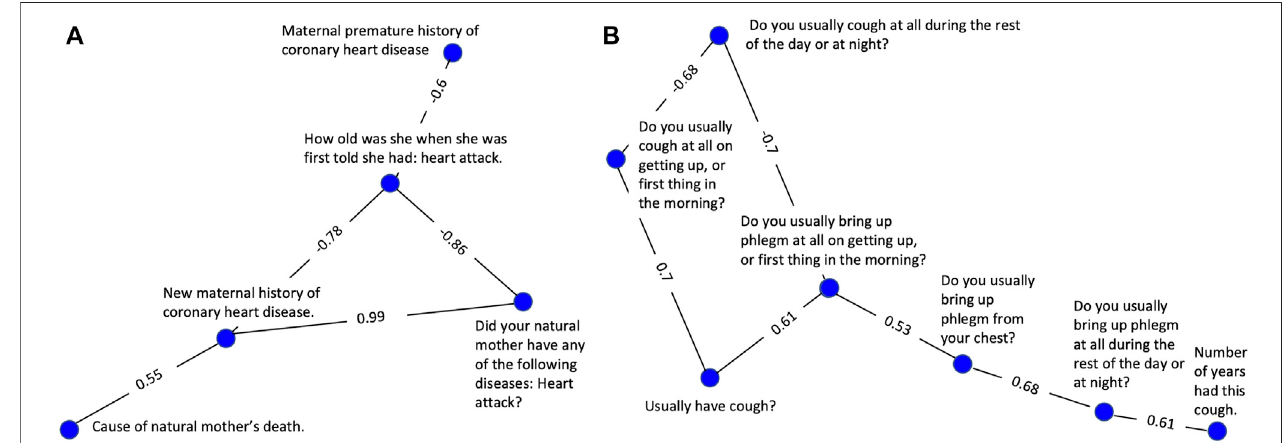
FIGURE 3 | (A) A depiction of the NLP-based cluster scoring process. (B) Pie chart of the manual scoring of the 391 variable clusters (C) Plot of cluster scores for clusters in the different relatedness categories.